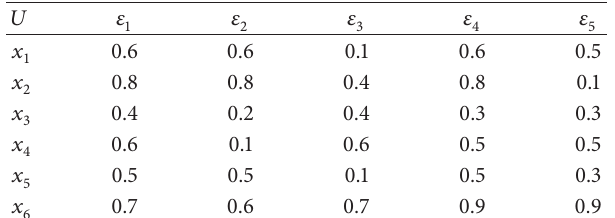
Table 3: Tabular representation of (𝐺,𝐵) .